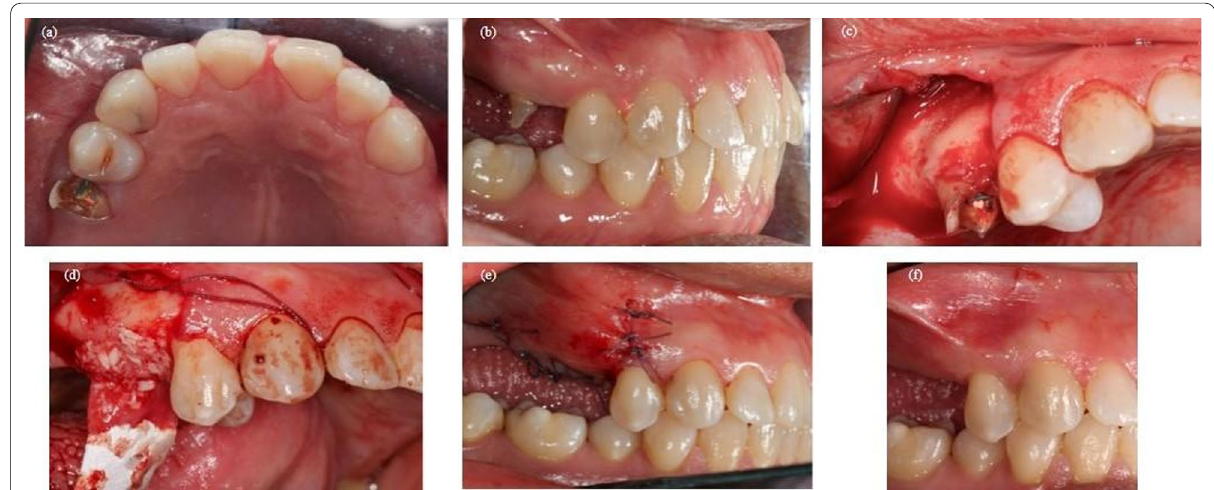
Fig. 1 Clinical case treated following the alveolar ridge preservation protocol. a Occlusal view of the fractured tooth. b Buccal view of the fractured tooth. c Mucoperiosteal flap elevation. d Post-extractive alveolus filled with the bone xenograft and covered with the resorbable membrane. e Suture of the surgical site. f Post-operative healing of the treated area